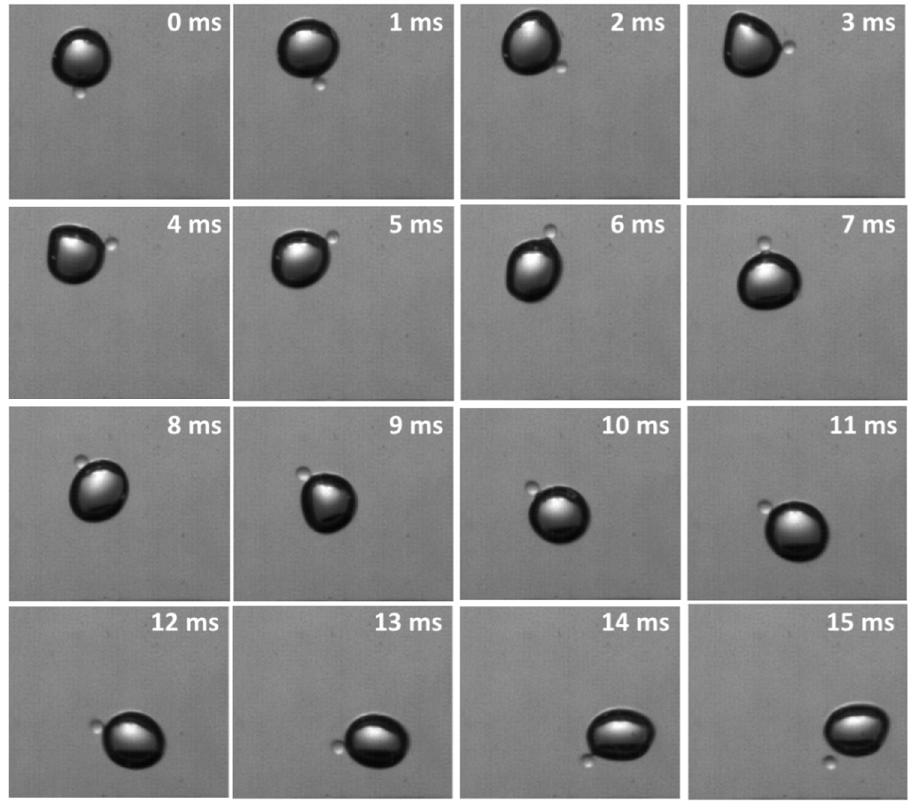
Figure 5. Time series of centrifugal movement of a particle on a bubble surface leading to detach- ment [70].